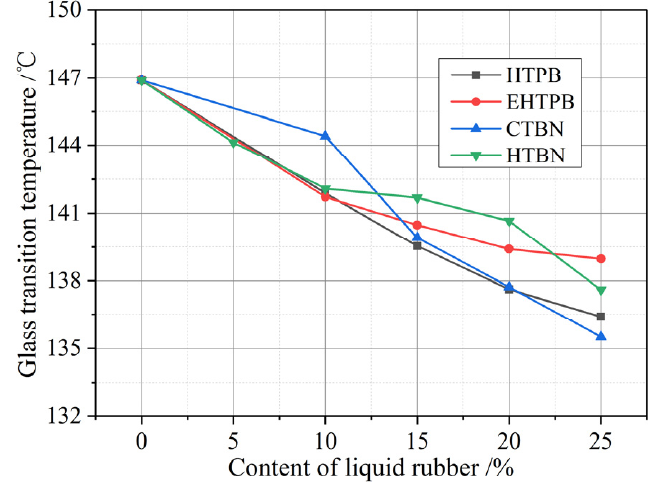
Figure 2. The glass transition temperature of epoxy resin matrix varies with the content of liquid rubber. The glass transition temperature decreases slightly with the increase of liquid rubber content.